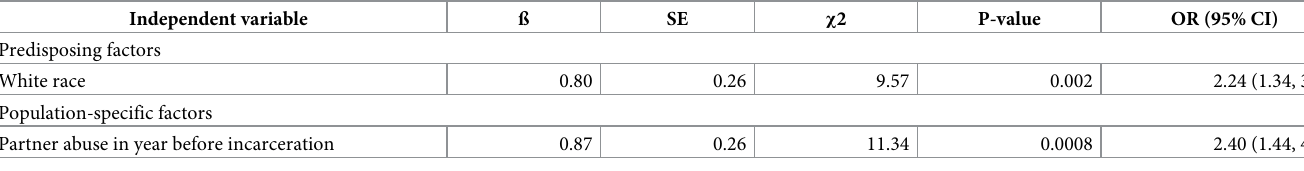
Table 5. Logistic regression model for dependent variable abnormal Pap test result, N = 290 a